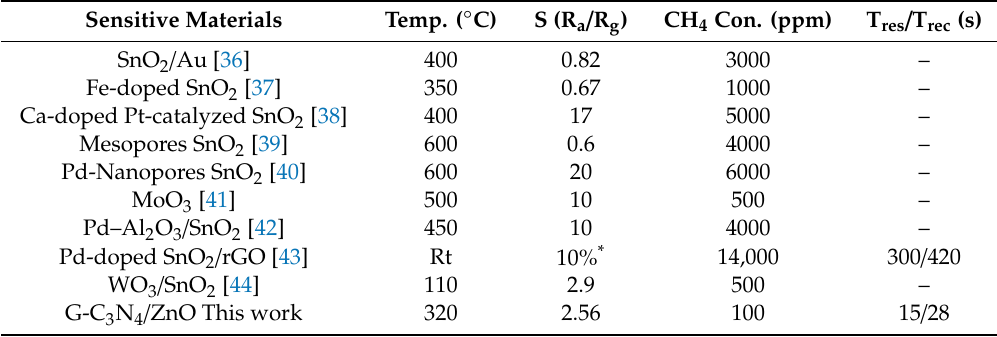
Table 1. Comparison of the CH 4 sensing performance of di ff erent reports. Sensitive Materials Temp. ( ◦ C)